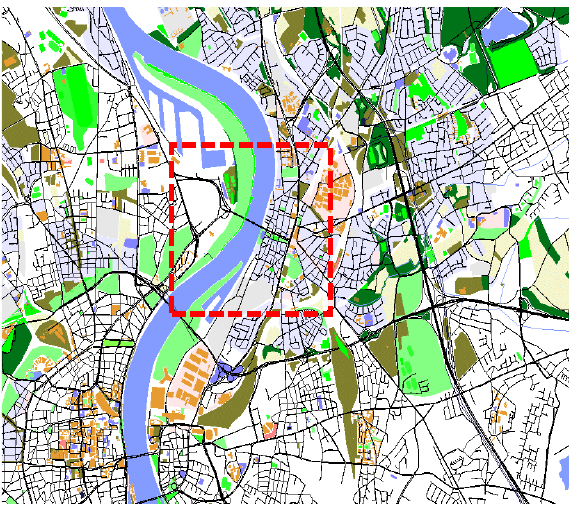
Figure 9. Map of Cologne considered for mobility generation. The bordered region contains 481 (rush hour) and 189 (idle hour) taxis and buses (VFN) and 67